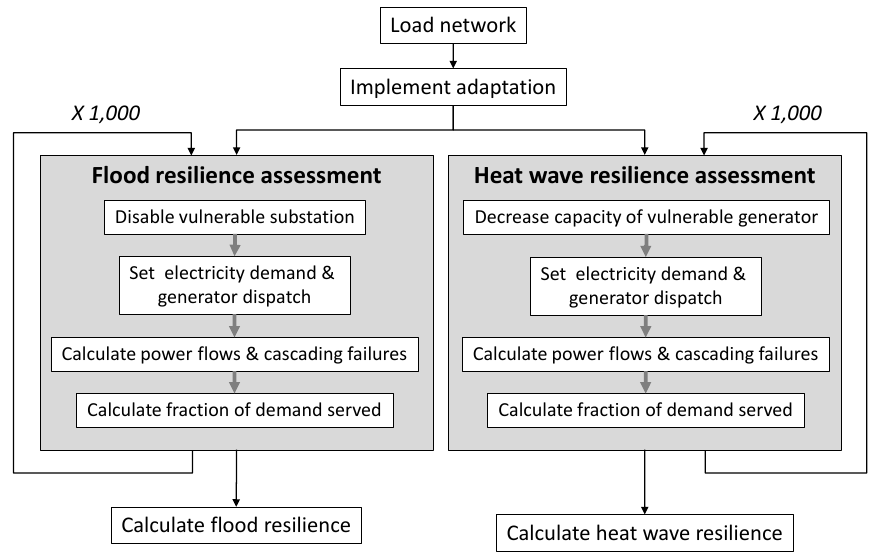
Figure 1. Flow diagram summarizing the model